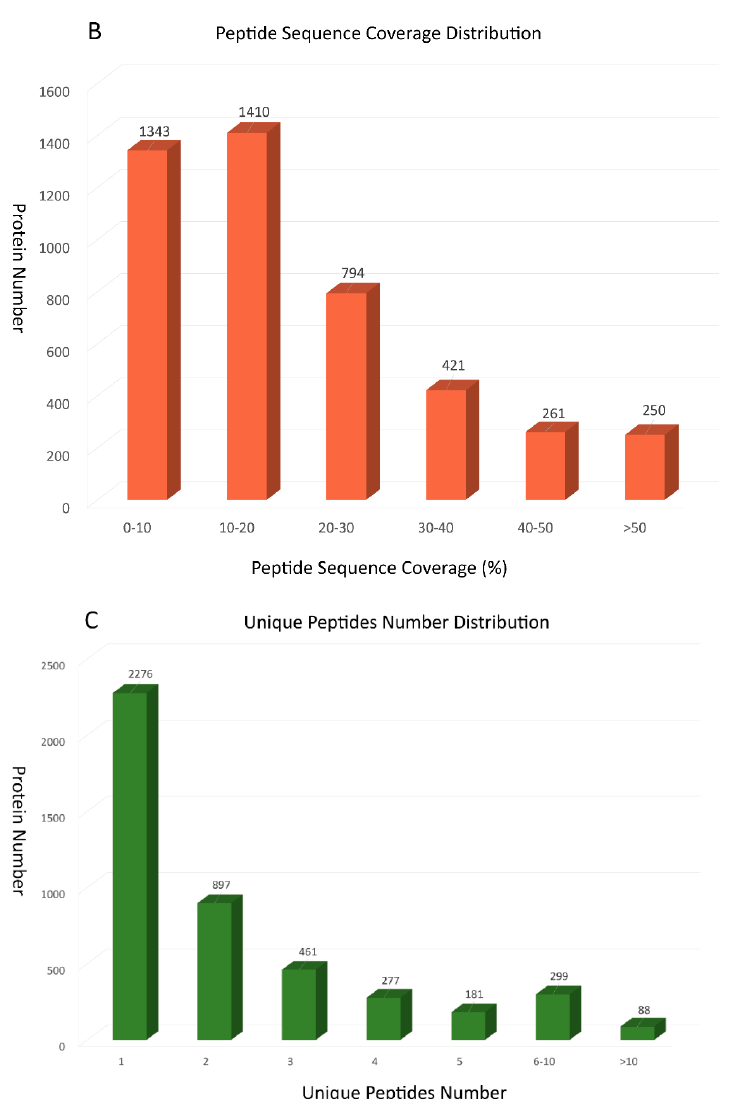
Figure 1. Summary for iTRAQ data: ( A ) The protein mass distribution shown as a histogram; ( B ) The peptide sequence coverage distribution shown as a histogram; ( C ) The number of unique peptides distribution shown as a